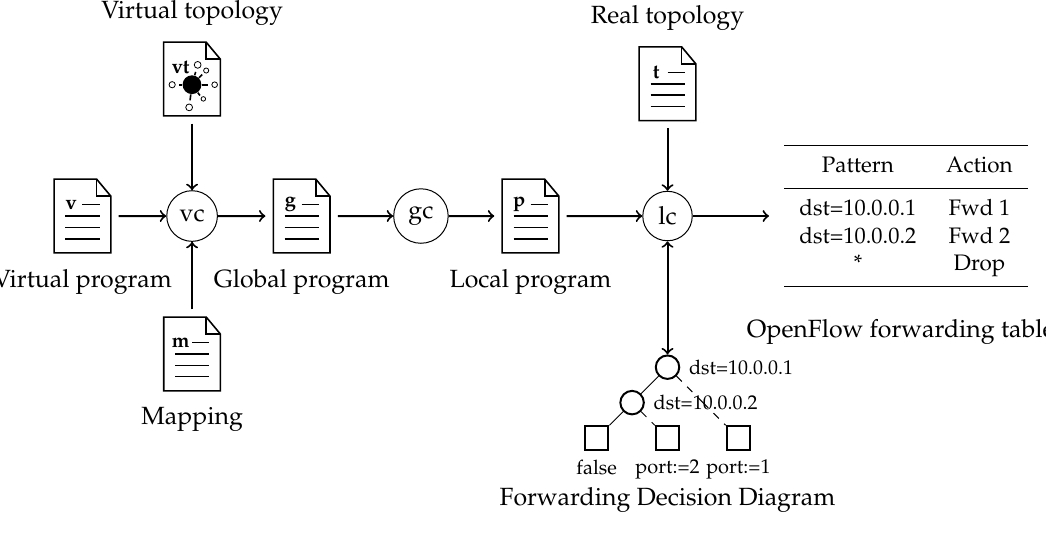
Figure 5. Frenetic compilation